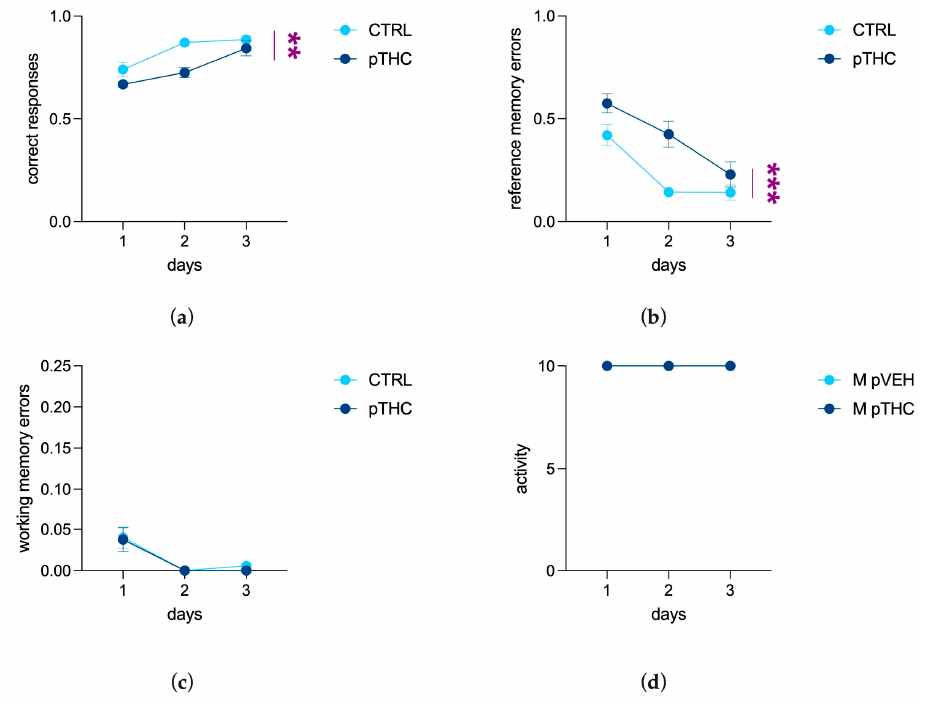
Figure 6. Effect of prenatal THC exposure (2 mg/kg) on the object recognition memory of the adolescent male rat offspring in the simple visual task of the Can test: ( a ) Prenatal exposure to THC decreased correct responses and ( b ) increased reference error memory of adolescent male rats. ( c ) No significant effect of prenatal THC treatment was detected in working memory errors and ( d ) activity. Each bar represents the mean of n = 9 rats in the CTRL group and n = 10 rats in the pTHC group; error bars indicate SEM. ** p < 0.01; *** p < 0.001; CTRL = male rat offspring prenatally exposed to Veh; pTHC = male rat offspring prenatally exposed to THC.